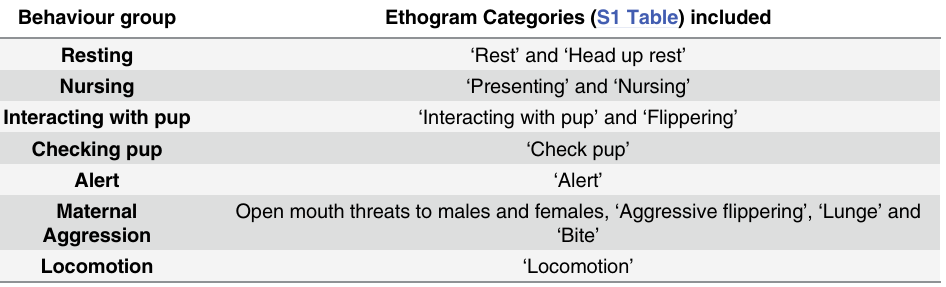
Table 2. The seven behaviour groups used for analysis with plasma oxytocin concentrations and the ethogram categories (S1 Table) included in them. Behaviour